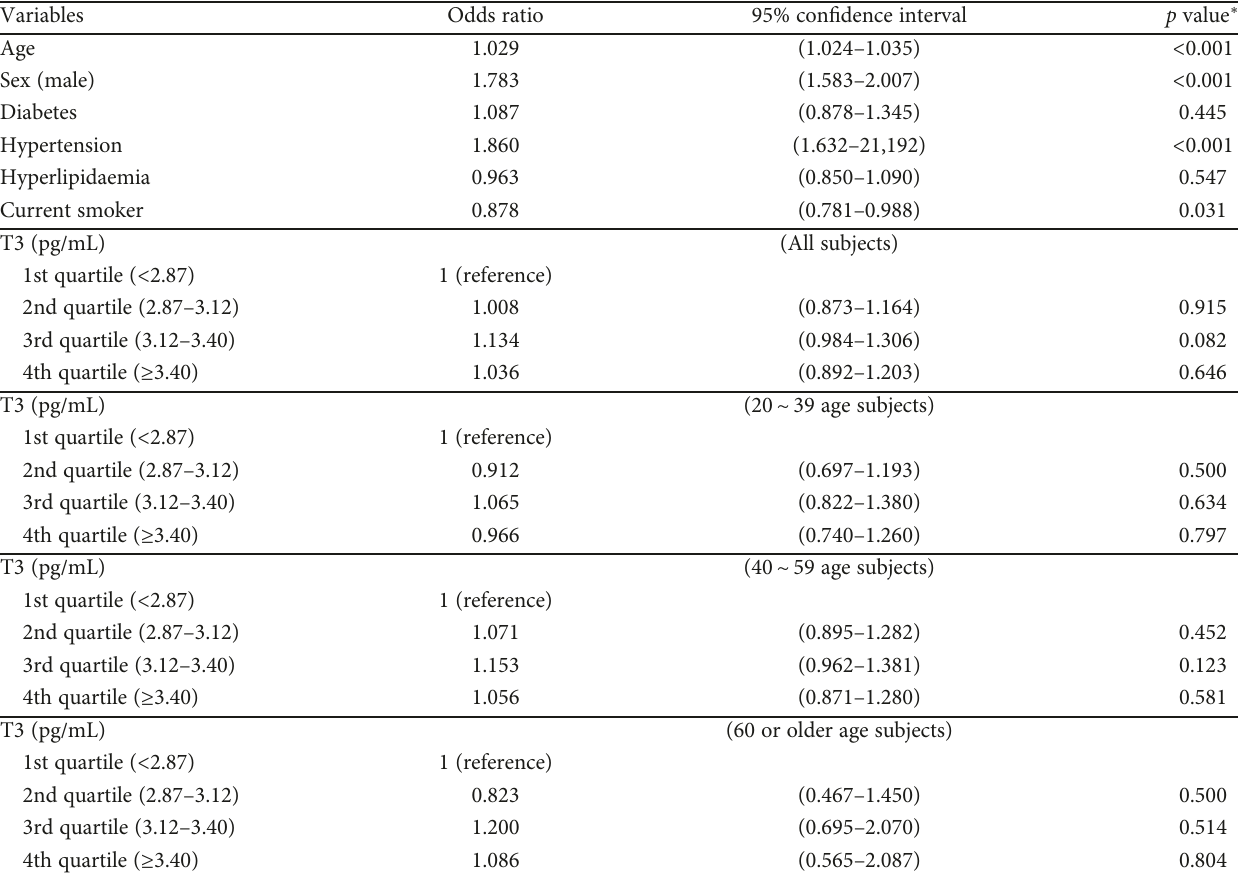
Table 6: Adjusted odds ratio and 95% con fi dence intervals of glaucoma strati fi ed by thyroid function.